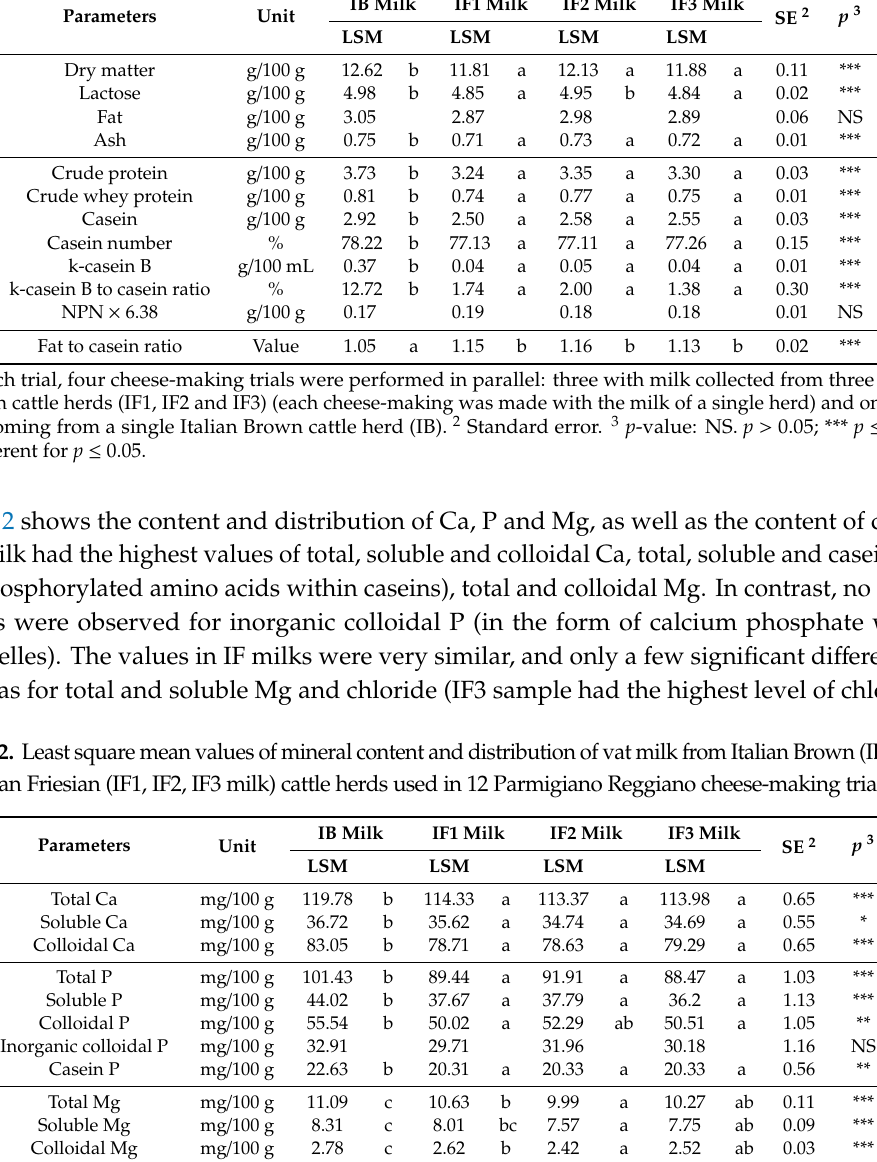
Table 1. Least square mean (LSM) values of chemical composition of vat milk from Italian Brown (IB milk) or Italian Friesian (IF1, IF2, IF3 milk) cattle herds used in 12 Parmigiano Reggiano cheese-making trials 1 . Parameters